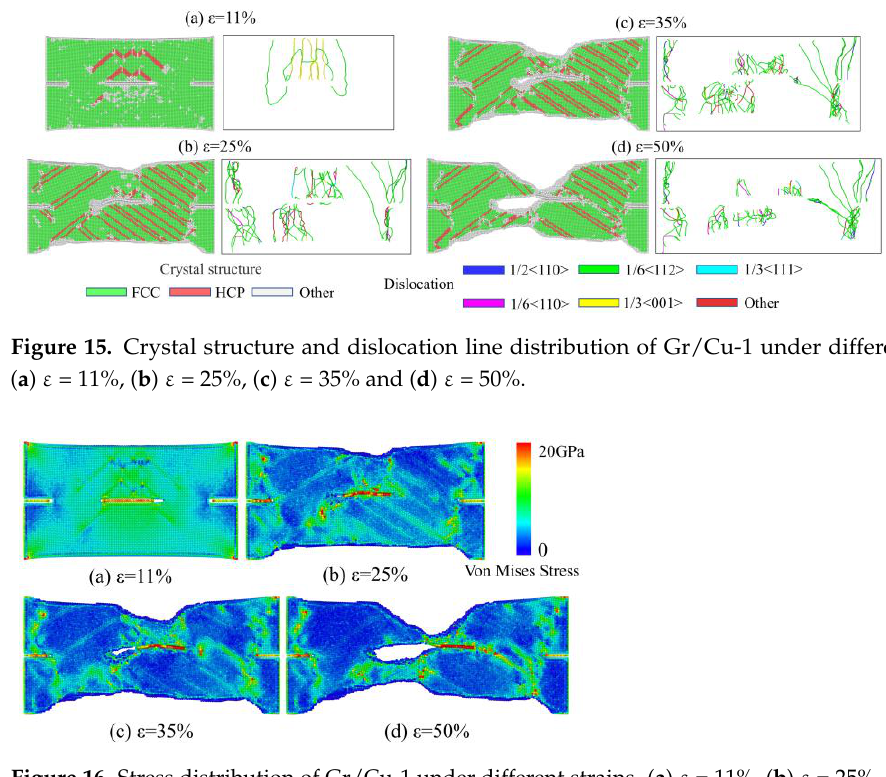
Figure 14. The dislocation density of Gr/Cu composites under different strains.